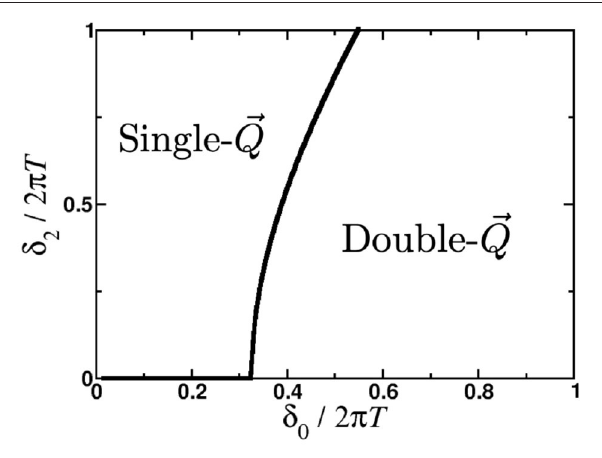
FIGURE 2 | Results of the numerical analysis of the coefficient g 4 in the free energy expansion for the clean system, Ŵ 0. The solid line marks the first = order transition line along which the coefficient g 4 is zero and the energies of the single- E Q and double- E Q states are